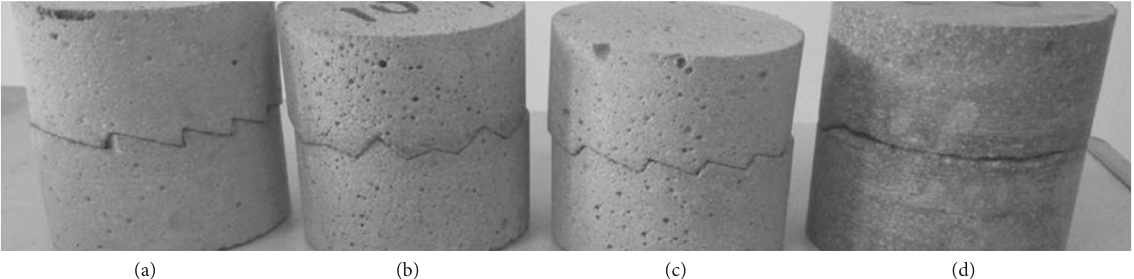
Figure 2: The precast model with different types of discontinuity and natural rough rock joint surface model. (a) Roughness type I model; (b) roughness type II model; (c) roughness type III model; (d) natural rough rock joint surface